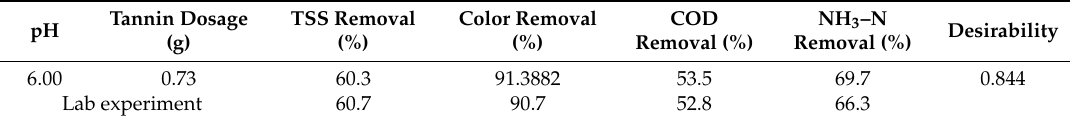
Table 5. Optimal Response results from model prediction and laboratory.